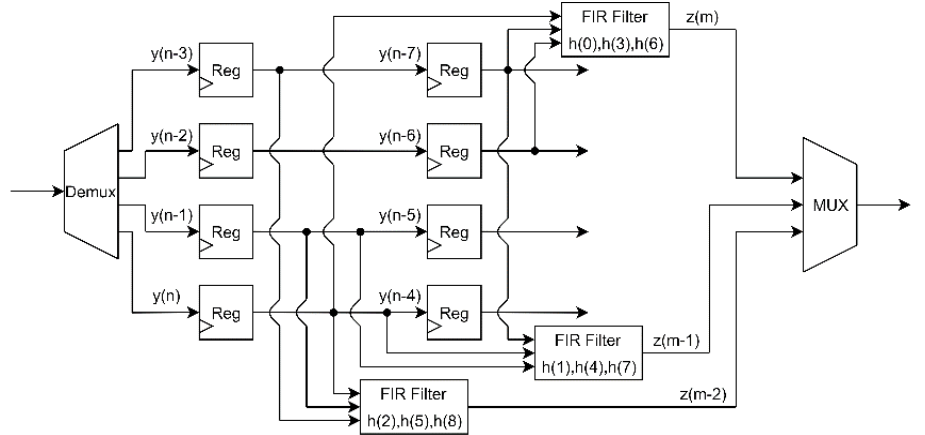
Figure 1. Schematic of a digital resampler implementation based on polyphase decomposition. Resampling factor equal to 3/4 low-pass filter with 9